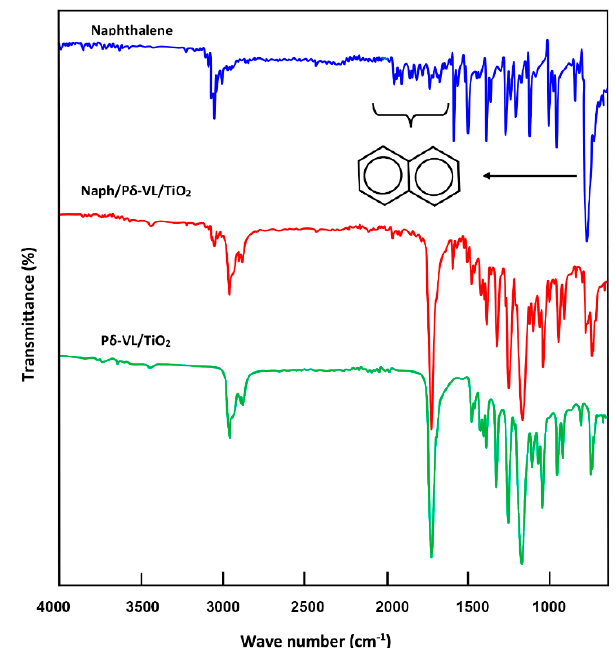
Figure 1. Comparative FTIR spectra of pure naphthalene, P δ -VL/TiO 2 -1 hybrid material before and after removing the naphthalene.